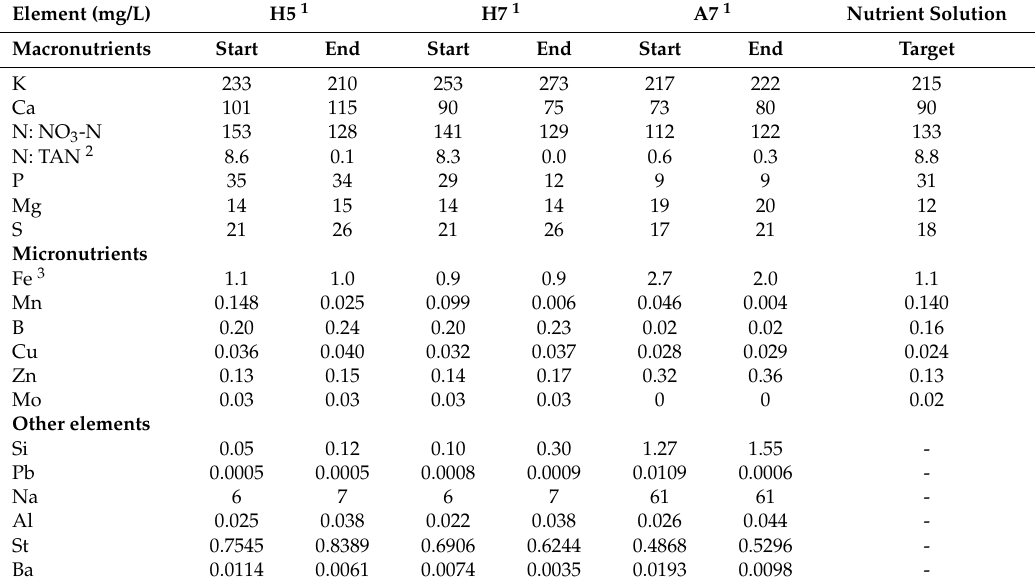
Table 2. Nutrient solutions’ starting, ending, and target concentrations, averaged by